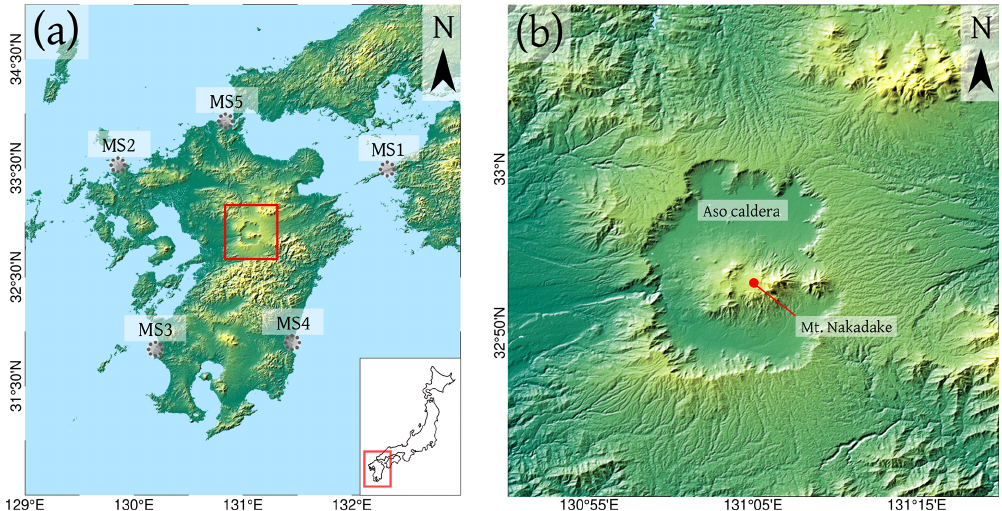
Figure 1. (a) Map of Kyushu Island (South Japan), where the Aso caldera is located (inside red rectangle). The positions of the five marker sites are indicated by dotted gray circles. A sketch showing the location of Kyushu Island within Japan is also displayed in the insert. (b) Zoom on the Aso caldera. Shuttle Radar Topography Mission (SRTM) digital elevation model (DEM) 1arcsec 30m (NASA,